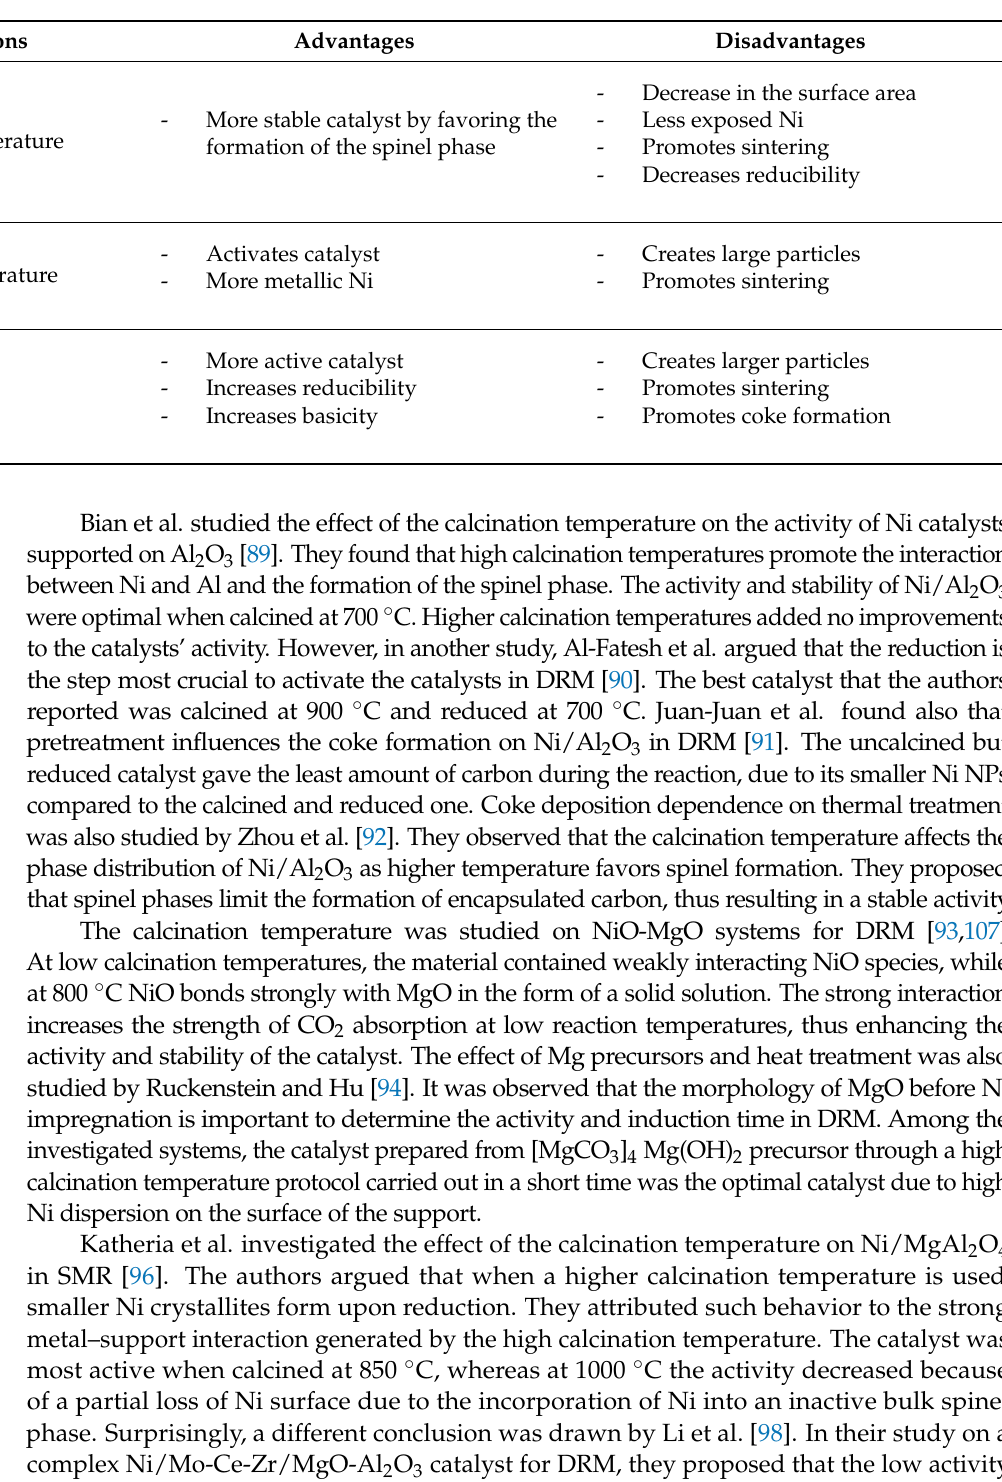
Table 3. General effects of synthesis conditions on Ni/Mg(Al)O